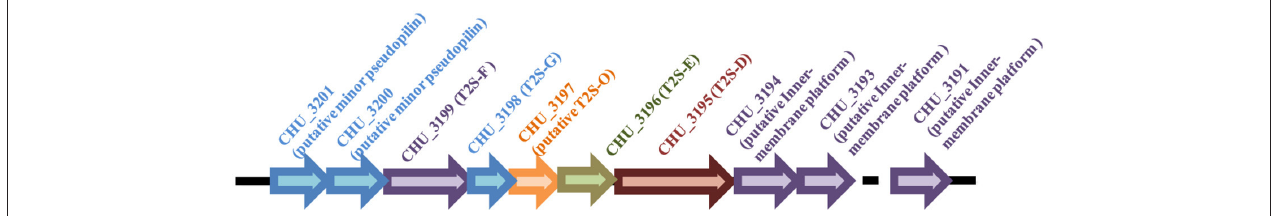
FIGURE 1 | Schematic illustration of the organization of the t2s gene loci in C. hutchinsonii genome.